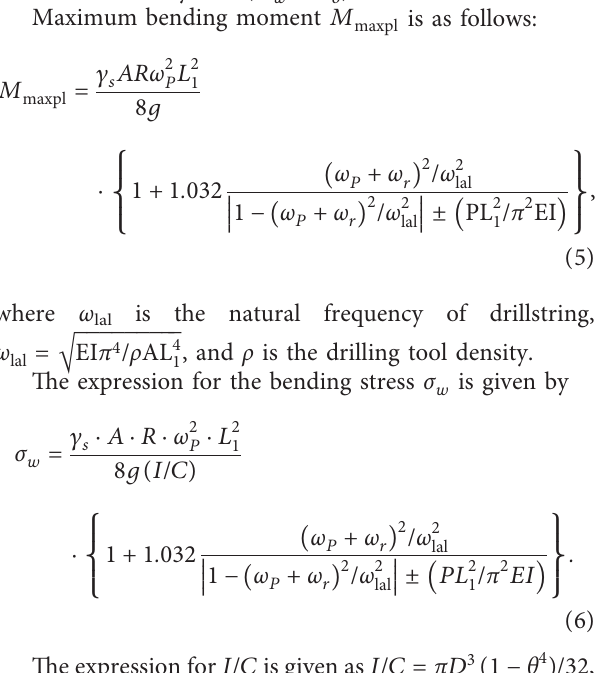
� rotation velocity, and ω r